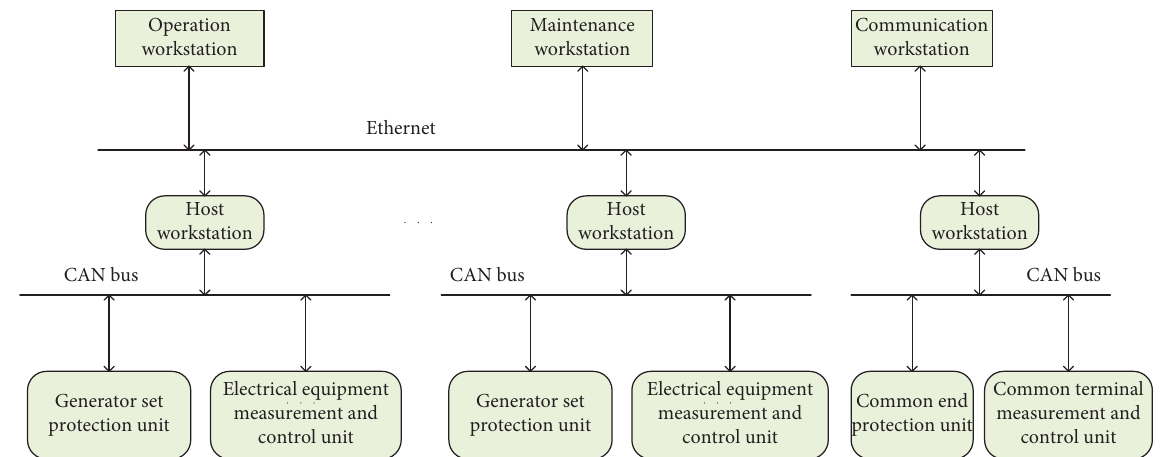
Figure 4: Structure diagram of the electrical automation monitoring